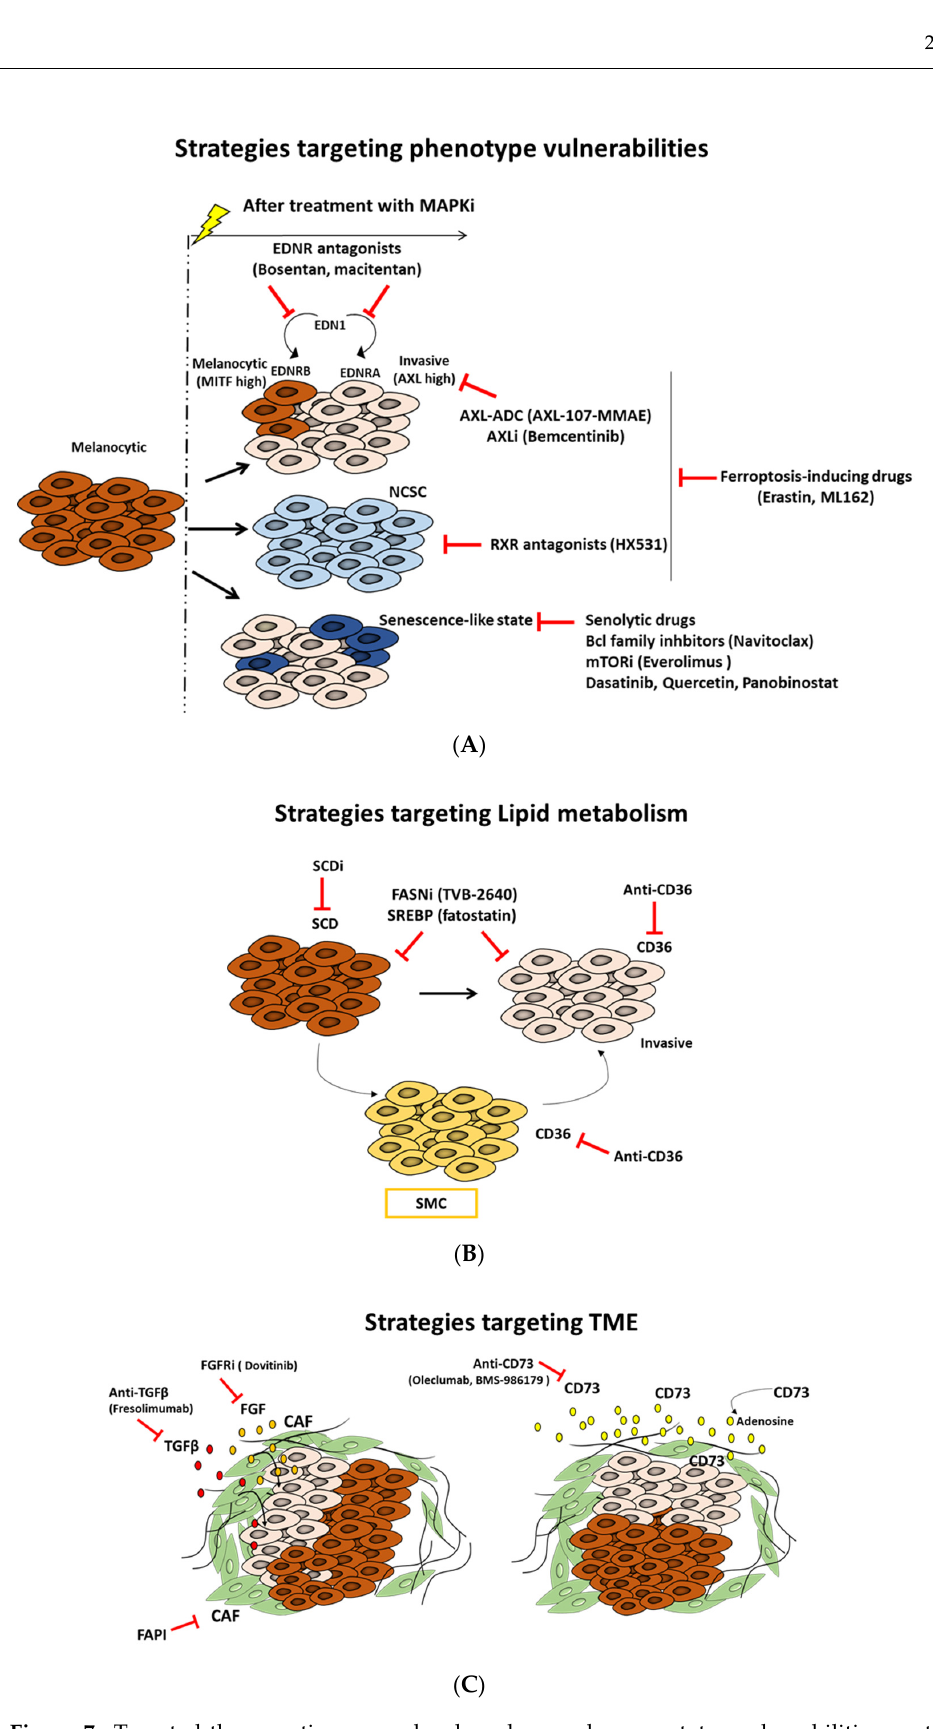
Figure 7. Targeted therapeutic approaches based on melanoma states vulnerabilities, metabolic rewiring, and microenvironment modulation. Schematic description of different therapeutic strate- gies: ( A ) exploiting vulnerabilities of distinct phenotypes, ( B ) targeting lipid metabolism, and ( C ) modulating components and signals of tumor microenvironment